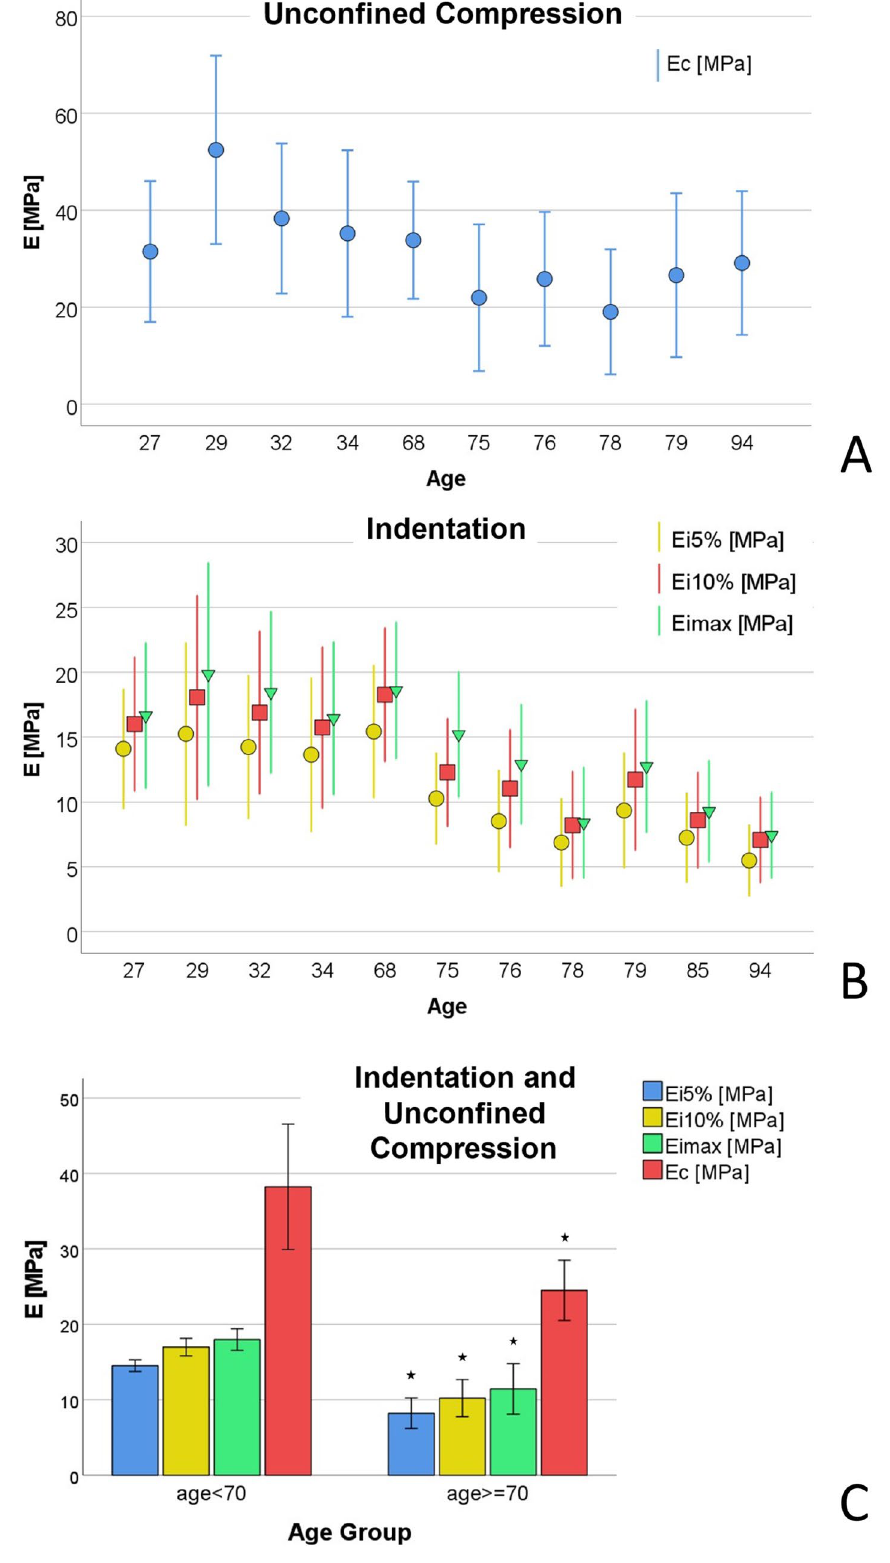
Figure 4. The effect of age. ( A ) Distribution of the Mean Young’s Modulus for the unconfined compression test E C over the age. ( B ) Distribution of the Mean Young’s Modulus for the indentation test E i5% , E i10% , E imax over the age. ( C ) Mean